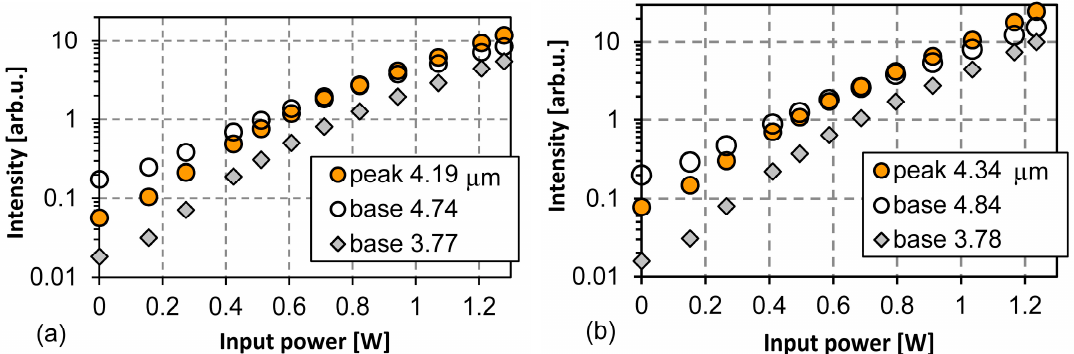
Figure 9. IR intensity as a function of the input power. The total membrane ring widths are ( a ) 500 μ m and ( b ) 1000 μ m. The vacuum package will decrease the loss and increase the intensity